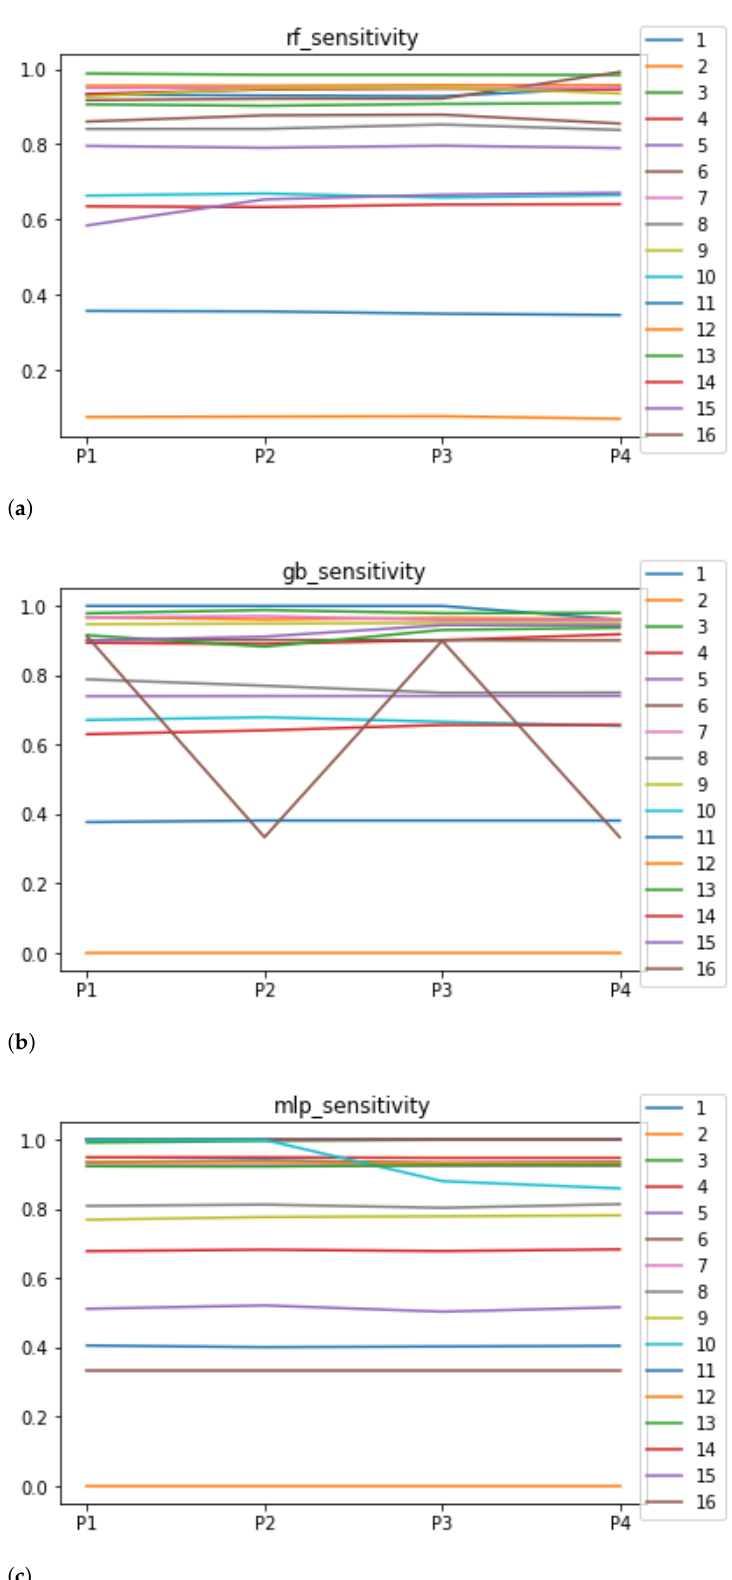
Figure 7. Behavior RHOASo: sensitivity. The datasets are represented with a bar chart for each partition. ( a ) Sensitivity for RF. Axis X: the partition of the dataset. Axis Y: the obtained sensitivity. ( b ) Sensitivity for GB. Axis X: the partition of the dataset. Axis Y: the obtained sensitivity. ( c ) Sensitivity for MLP. Axis X: the partition of the dataset. Axis Y: the obtained